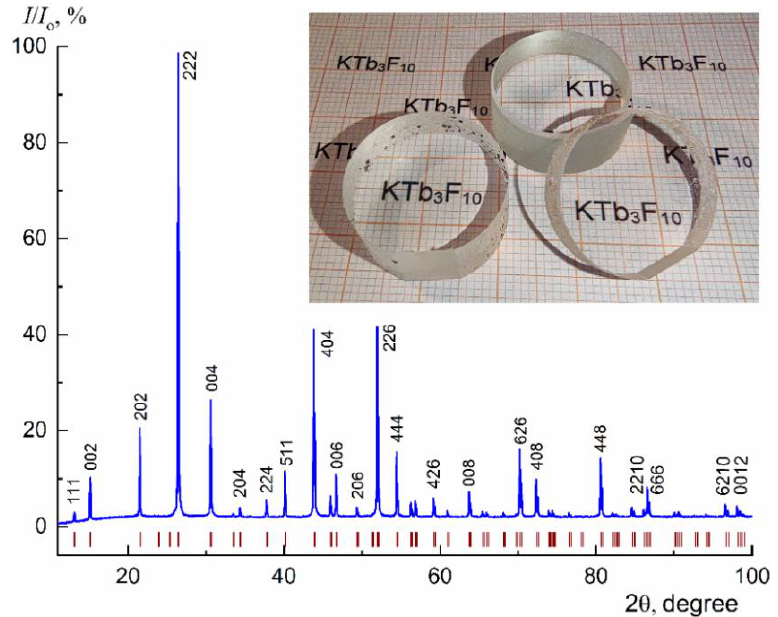
Figure 1. XRD pattern of the KTF crystal. The positions of the Bragg reflections peak within sp. gr. Fm – 3 m (the lattice parameter a = 11.6732(2) Å ) are indicated. Optical elements fabricated from the grown crystals are demonstrated in the insert.